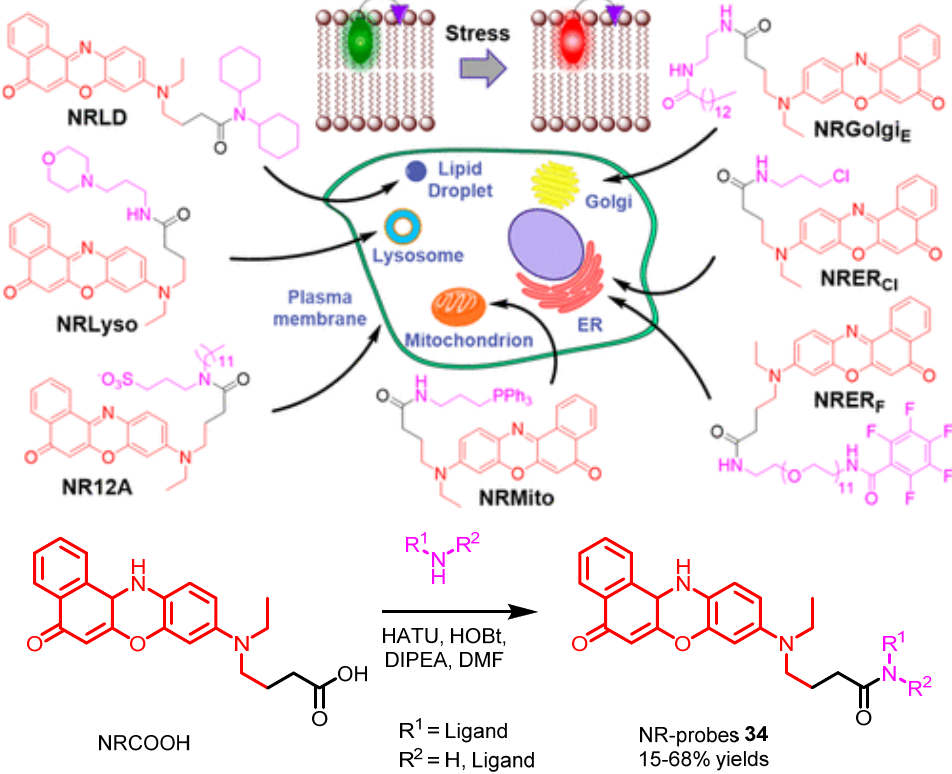
Scheme 27. Top : Organelle-targeted probes based on Nile Red. Bottom : Synthesis of probes 34 . Adapted from [72].